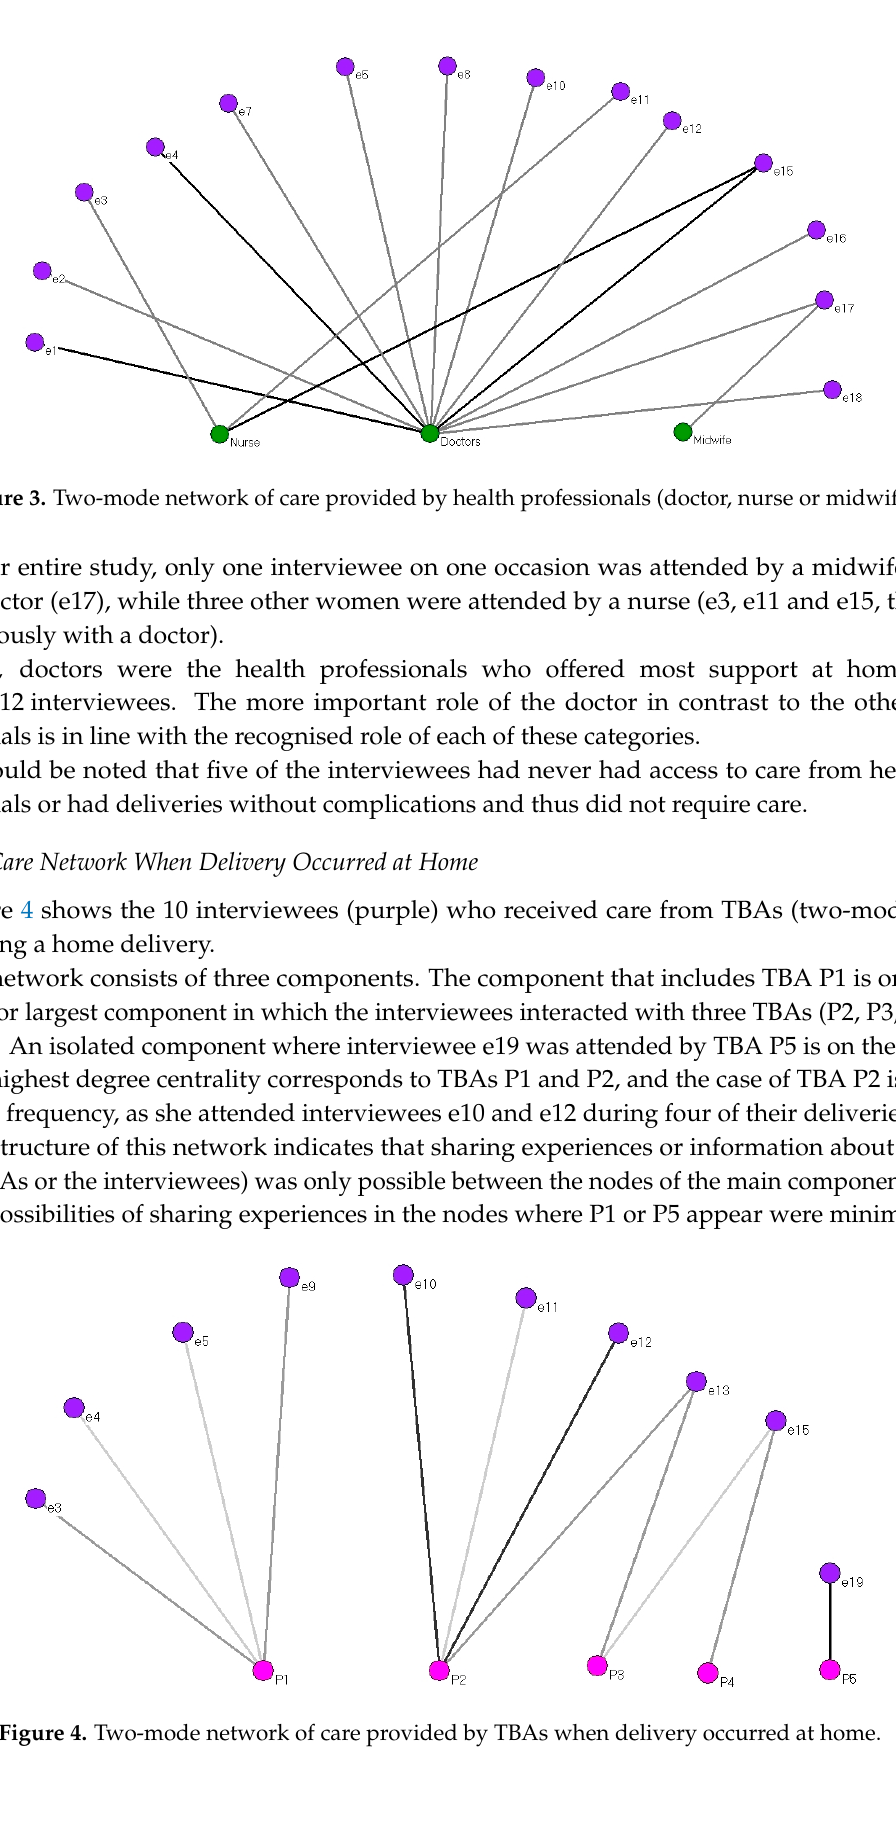
Figure 3. Two-mode network of care provided by health professionals (doctor, nurse or